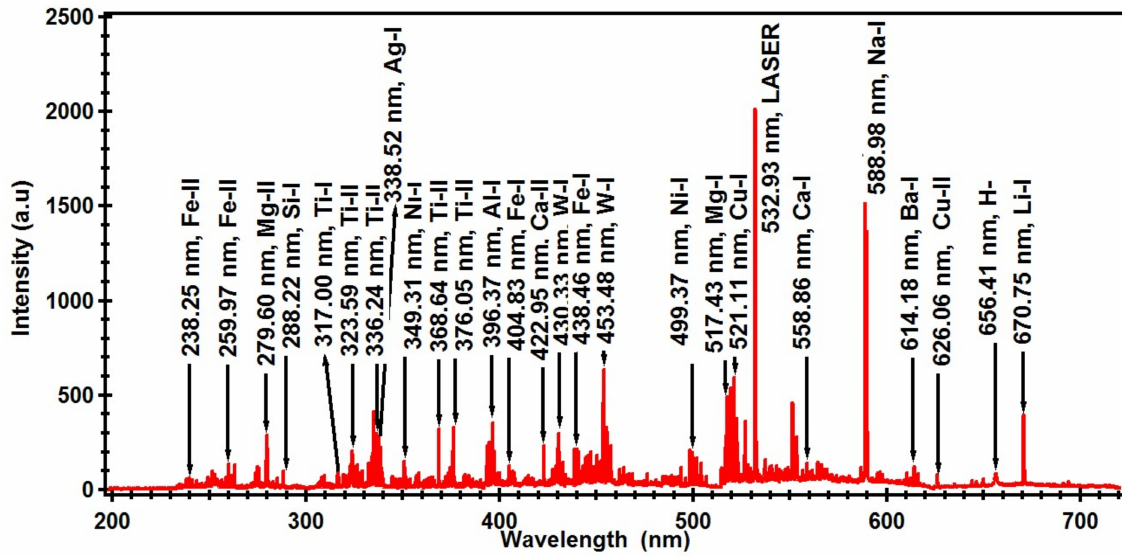
Figure 2. Obtained optical emission spectrum from laser-produced plasma of astrophyllite in the spectral range of 200–720